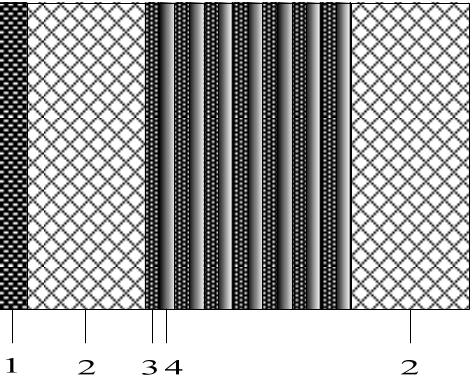
Figure 10. Calculation model. Table 1. Material